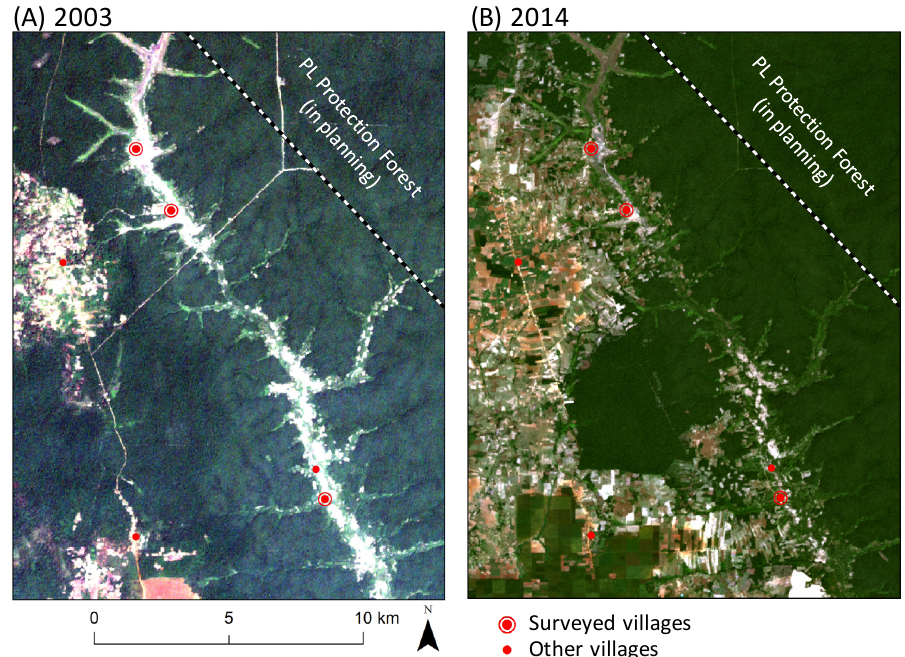
Figure 2. Land cover change from early 2003 ( A ) to early 2014 ( B ).